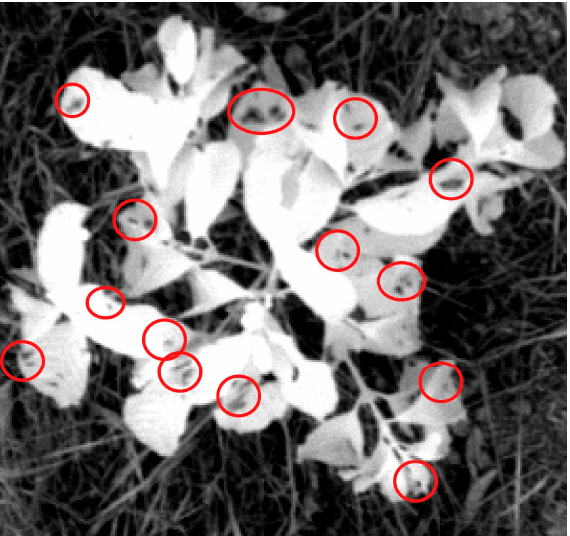
Figure 6. Infested plant in the field with mines of coffee leaf miner highlighted in red. According to Franklin [6], the females of the coffee leaf miner oviposit on the upper side of the leaves, which hatch and penetrate the leaf epidermis, starting the feeding from the leaves and formation of the mines. The mines have a rounded shape and are colored light brown, the darker color is due to the accumulation of excretions. We recommend future research on this topic to be carried out in areas with different levels of infestation. In addition, we recommend the use of deep learning algorithms and the random forest algorithm as in the studies by Marin [26] and Kagan [27]. 4. Conclusions It conclusion, that research showed that, on average, healthy plants showed higher VI values compared to infested plants. Additionally, GRNDVI best differentiated healthy plants from infested plants compared with other VIs. Author Contributions: L.M.d.S.: conception of the research, data acquisition, data analysis and in- terpretation, preparation of the study, writing and review of the study; G.A.e.S.F.: supervision and review of the study; D.B.M.: data analysis, interpretation, and review of the study; M.A.d.F.C.: su- pervision and review of the study; J.E.L.D.: review of the study; A.d.O.A.: data acquisition; M.d.L.O.e.S. review of the study. All authors have read and agreed to the published version of the manuscript. Funding: To Coffee Research Consortium EMBRAPA CAFÉ for funding the research and propaga- tion of the study. Institutional Review Board Statement: Not applicable. Informed Consent Statement: Not applicable. Data Availability Statement: Not applicable. Acknowledgments: We would like to thank the Embrapa Brazilian Coffee Research Consortium, the National Council for Scientific and Technological Development (CNPq), the Coordination for the Improvement of Higher Education Personnel (CAPES), the Federal University of Lavras (UFLA), and the Farm Cafua. Conflicts of Interest: The authors declare no conflict of interest. References 1.